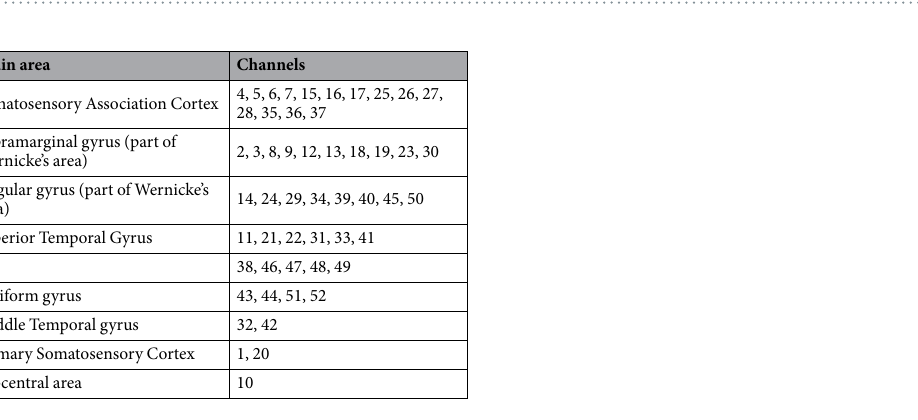
Table 3. Demographic variables of the depressed and non-depressed group. MADRS = the Montgomery– Åsberg Depression Rating Scale, PHQ-9 = Patient Health Questionnaire, RRS = Rumination Response Scale, FAF = Fight Against Fatique.